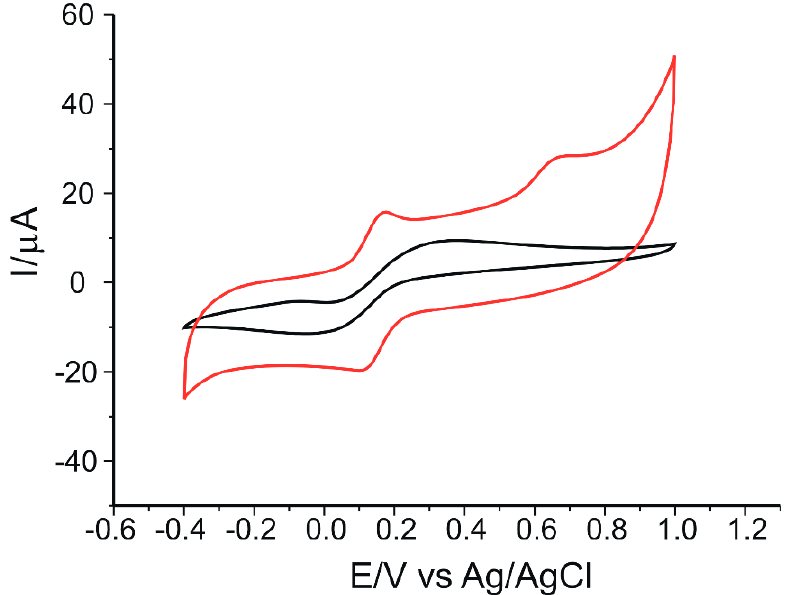
Figure 8. Cyclic voltammograms of GO/SPCE (black line) and GO-Peptide/SPCE (red line) immersed in 10 − 3 M K 4 [Fe(CN) 6 ]/K 3 [Fe(CN) 6 ]-0.1 M PBS solution, at the scan rate of 0.05 V·s − 1 .